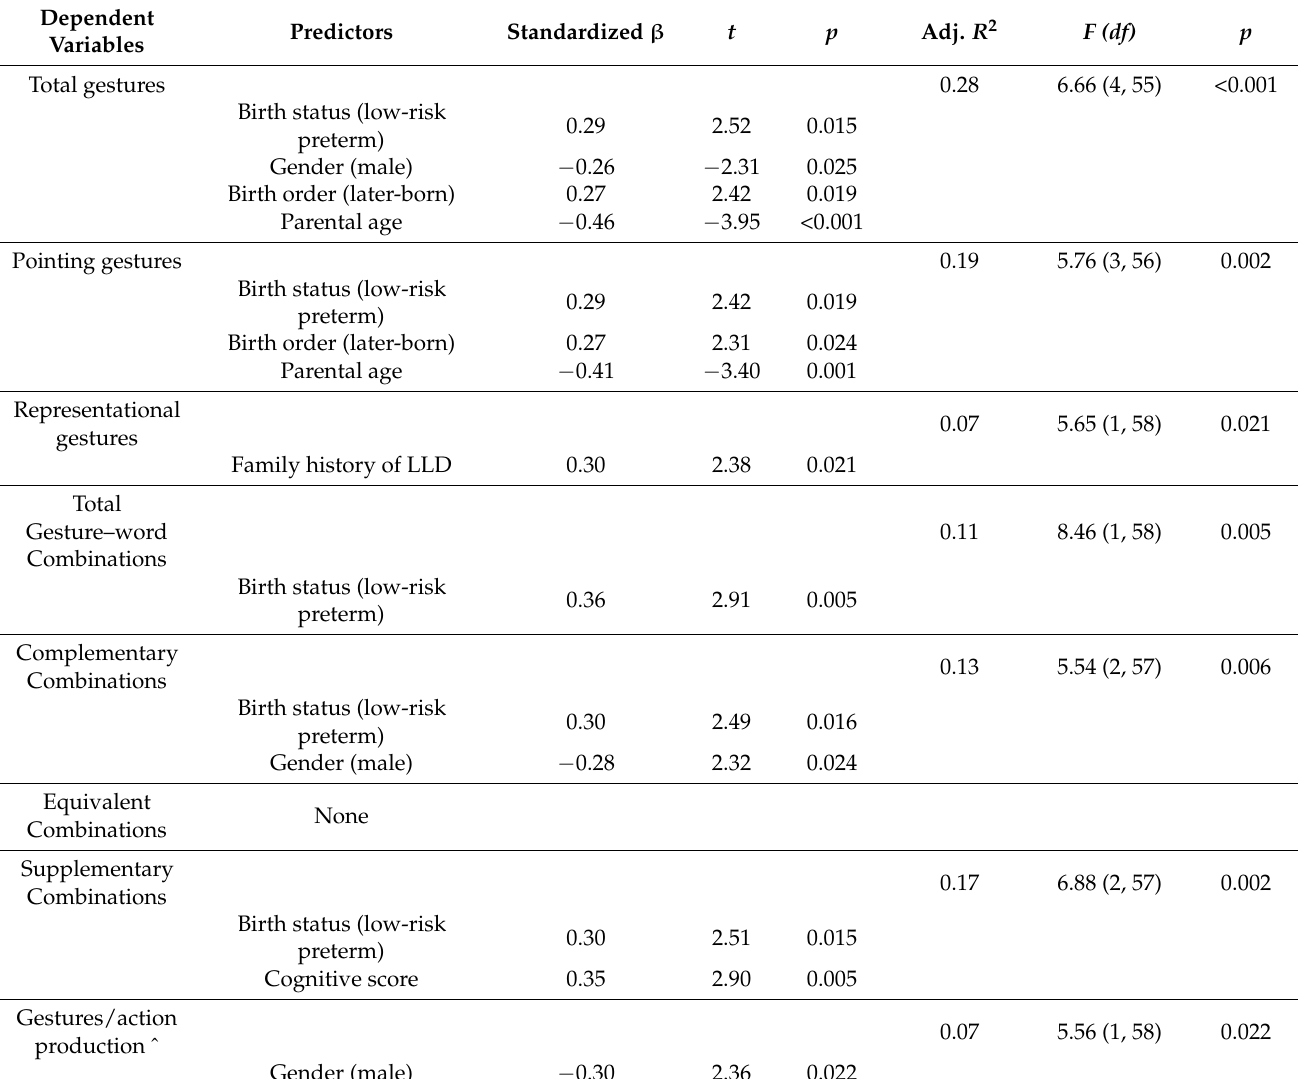
Table 5. Results of multiple linear regression analyses on late talkers’ use of gestures and gesture– word combinations in the book-sharing session and gesture/action production reported at the